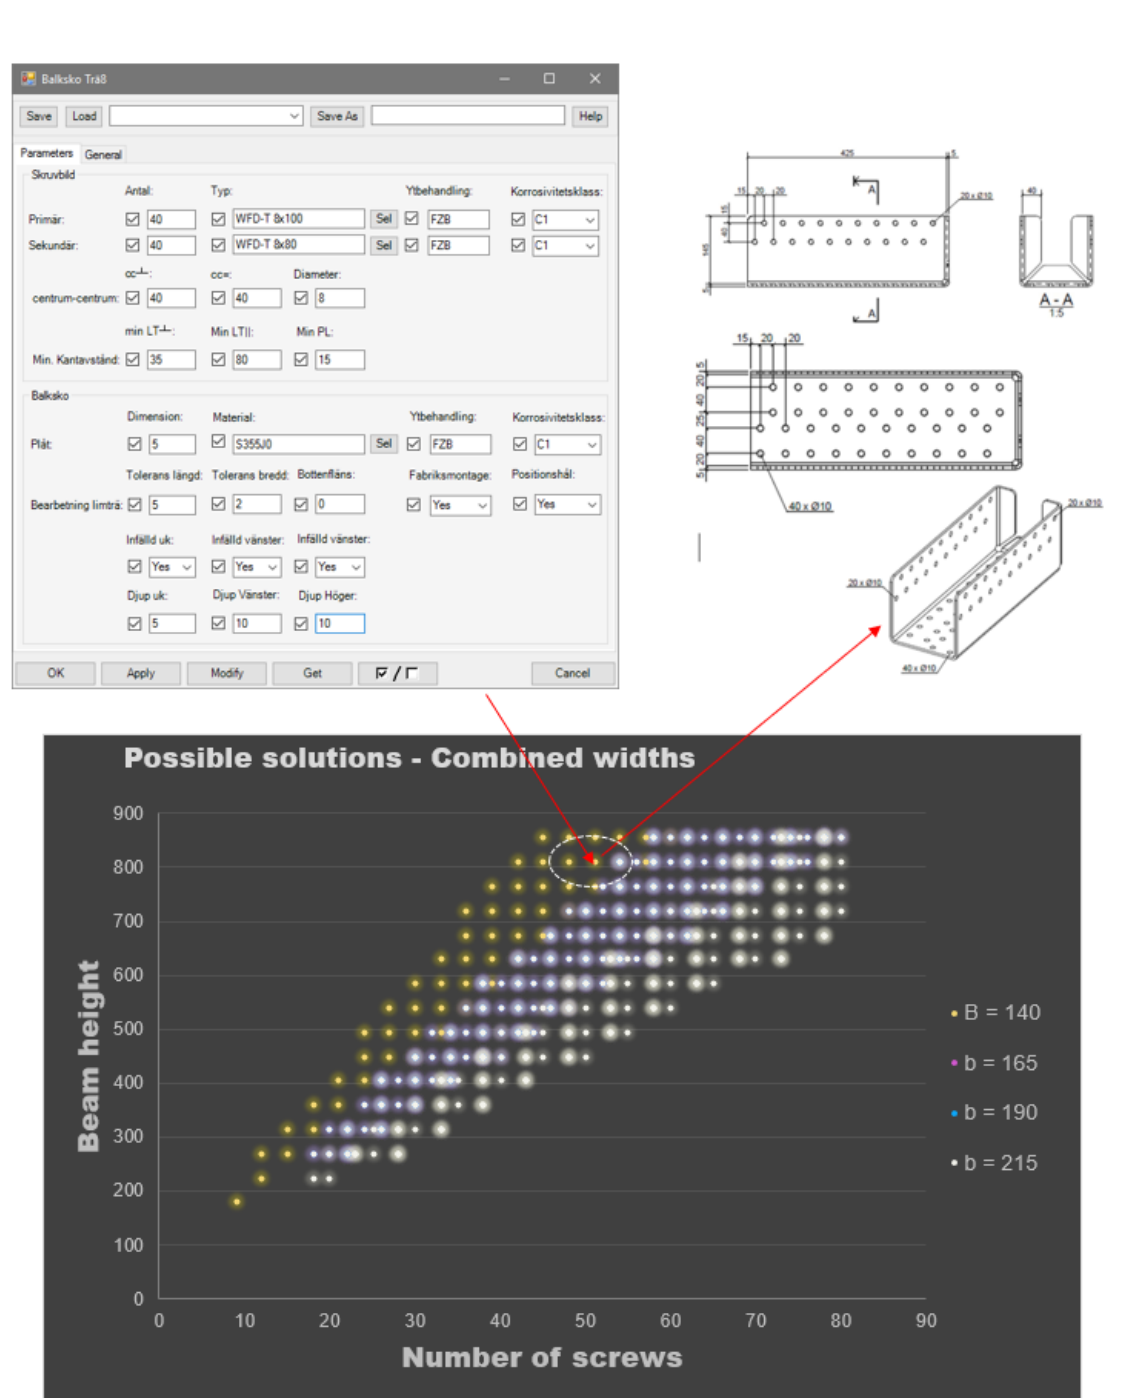
Figure 6. A possible solution in the bracket design solution space.